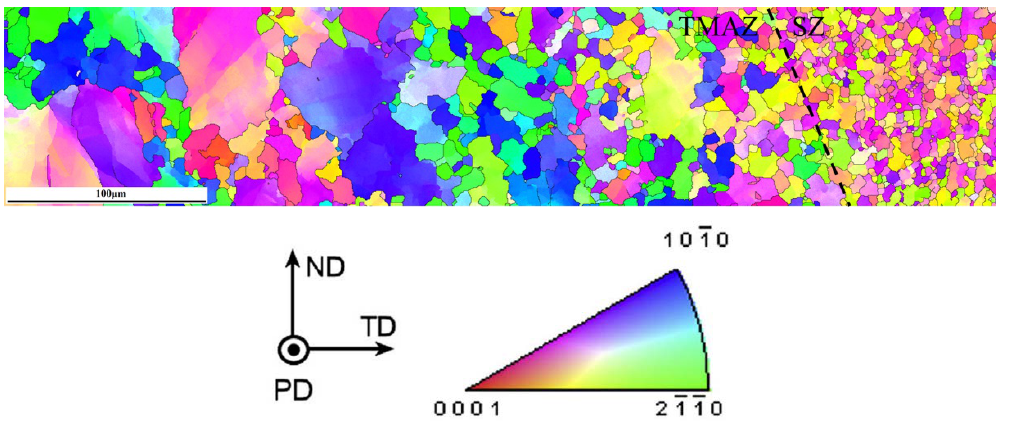
Figure 9. Inverse pole figure maps of region A in the Mg–6Sn–2Zn sample with a travel speed of 60 mm/min.